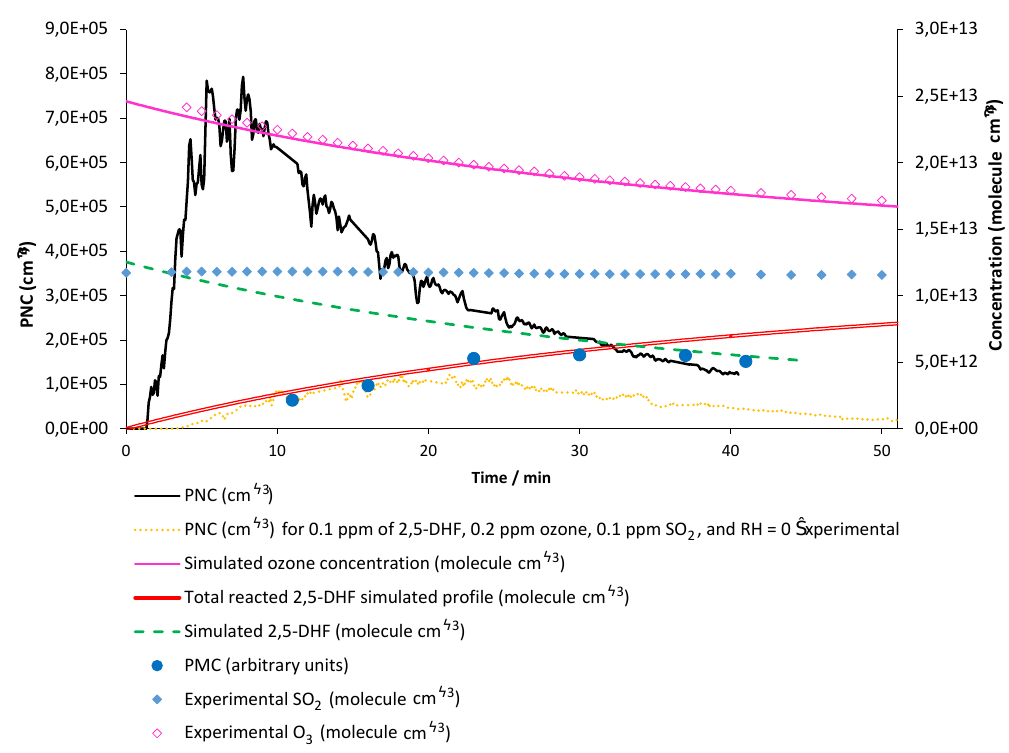
Figure 2. Temporal profiles for particles and gases. Initial concentrations: 0.5ppm of 2,5-DHF, 1ppm of O 3 , 0.5ppm of SO 2 and RH = 0.